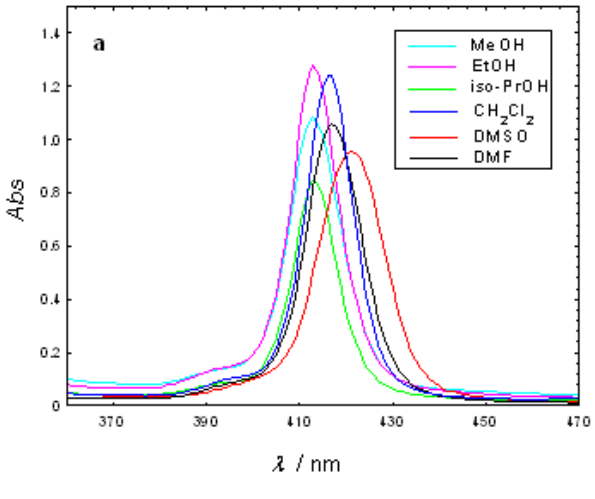
Figure 2. Absorption spectra of 2.5 × 10 -6 M Cu(II)TCMP in different solvents ( a -Soret band; b -Q